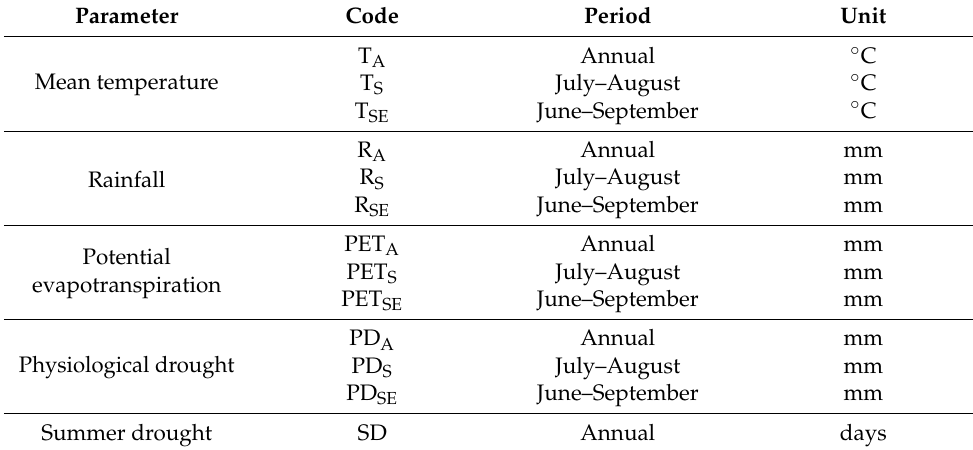
Table 2. Studied parameters. Parameter